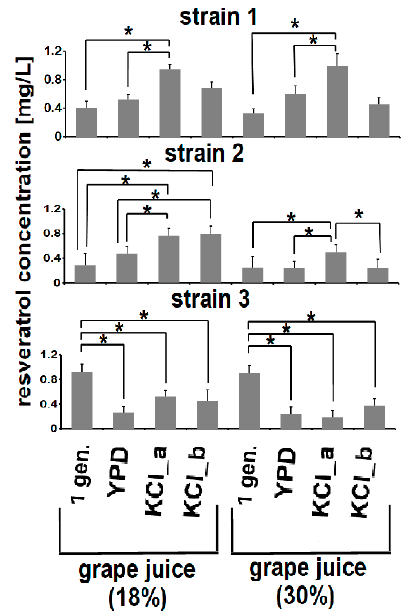
Figure 4. Concentrations of resveratrol [mg / L] after the end of fermentation. Grape juice containing 18% sugars (10.2 g / L glucose and 7.7 g / L fructose) or 30% sugars (15.82 g / L glucose; 13.55 g / L fructose) were used as fermentation media. Data are presented as the means ± SD; n = 3. Significant differences are marked by * (at p < 0.05). 1 gen—1st generation (ancestral strains); YPD–YPD-evolved